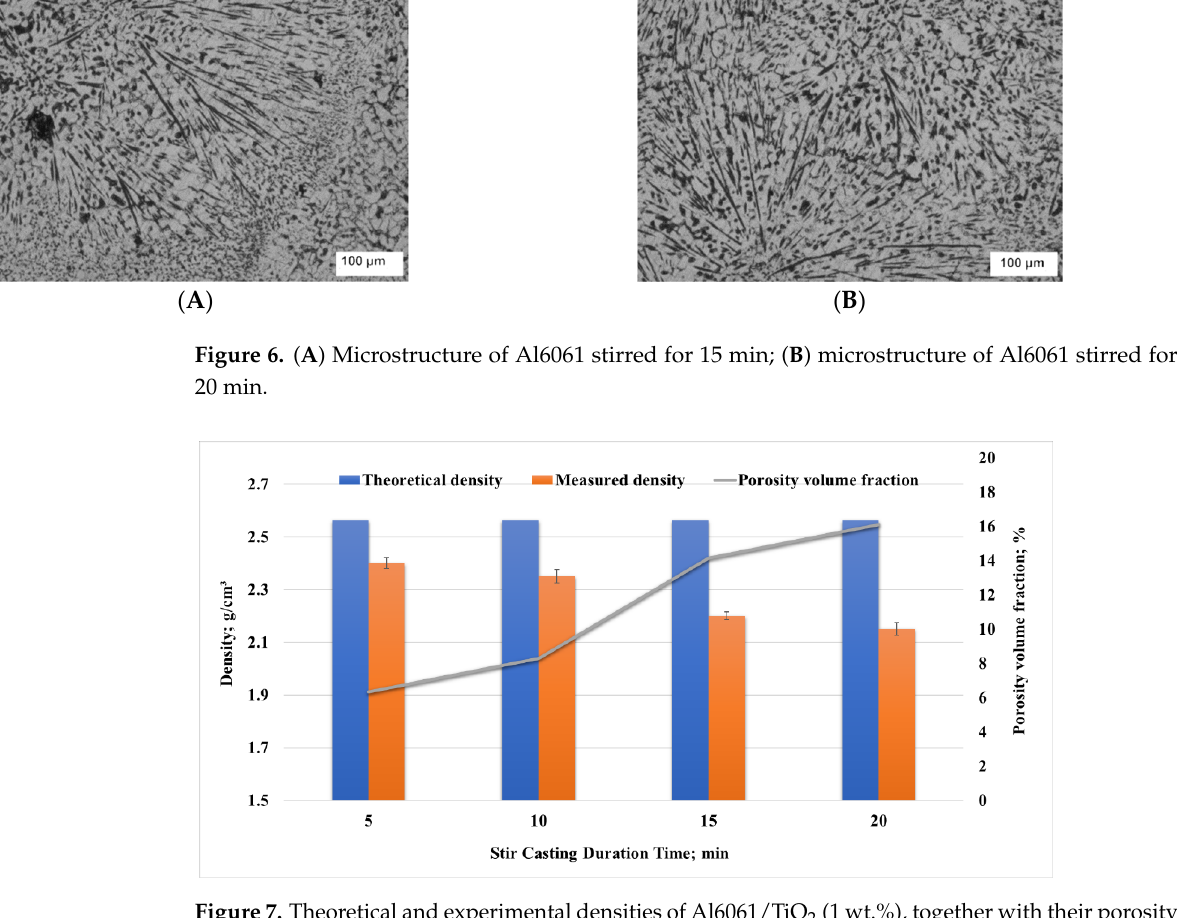
Figure 8. EDX of the stirrer material.